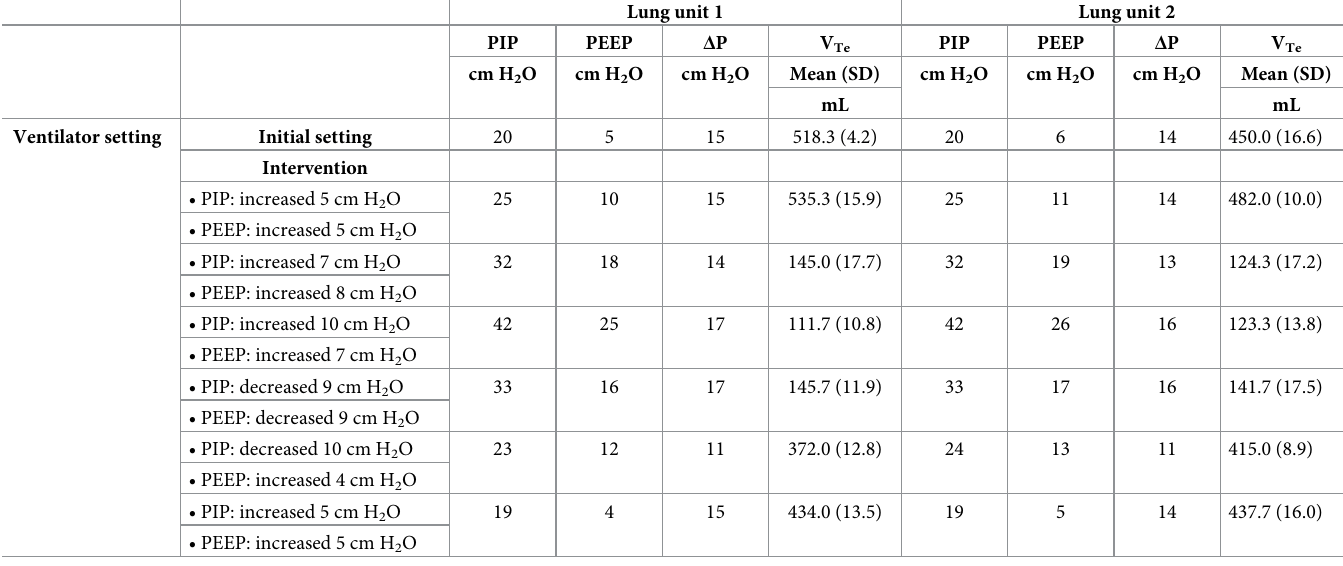
Table 1. Proposed variations on the peak inspiratory pressure and positive end-expiratory pressure of the ventilator and the resulting values of peak inspiratory pressure, positive end-expiratory pressure, driving pressure and expired tidal volume on each lung